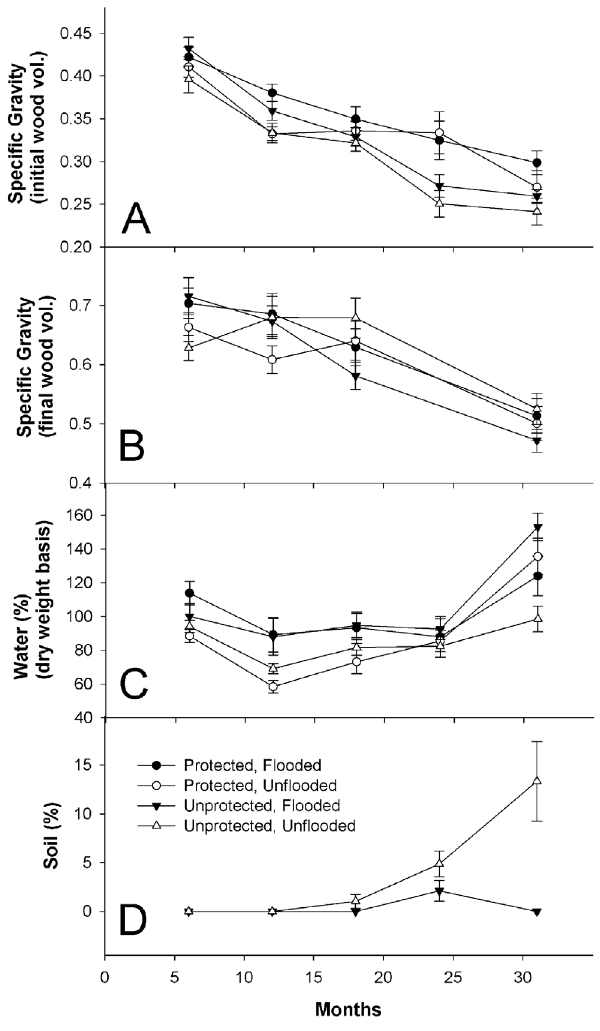
Figure 4. Mean 6 SE specific gravity (initial wood volume) (A), specific gravity (final wood volume) (B), water content (C) and soil content (D). Note: data on specific gravity (final wood volume) were not collected at 24 months.